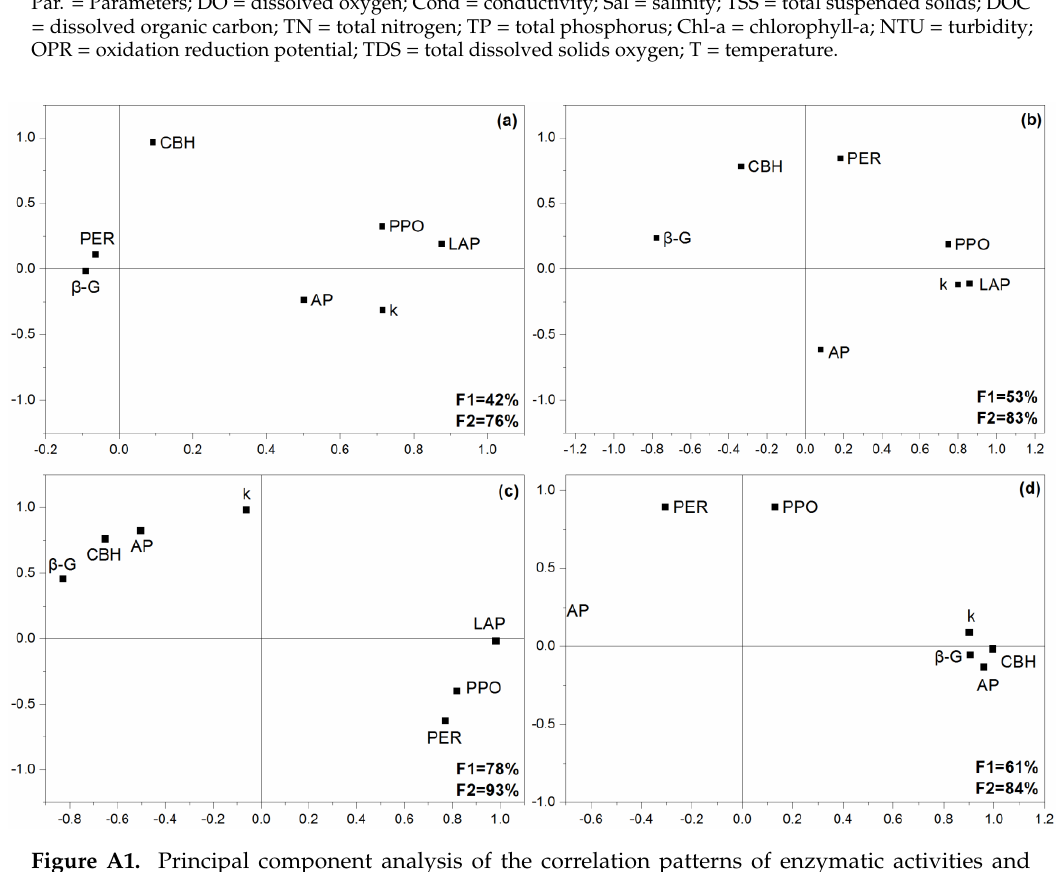
Figure A1. Principal component analysis of the correlation patterns of enzymatic activities and litter decomposition rate (k) in the natural light simulation group without cadmium (N) ( a ), ALAN simulation group without cadmium (A) ( b ), natural light simulation group with cadmium (N-Cd) ( c ), and ALAN simulation group with cadmium (A-Cd) ( d ). AP, acid phosphatase; β -G, β -Glucosidase; CBH, cellobiohydrolase; LAP, leucine-aminopeptidase; PPO, polyphenol oxidase; PER,